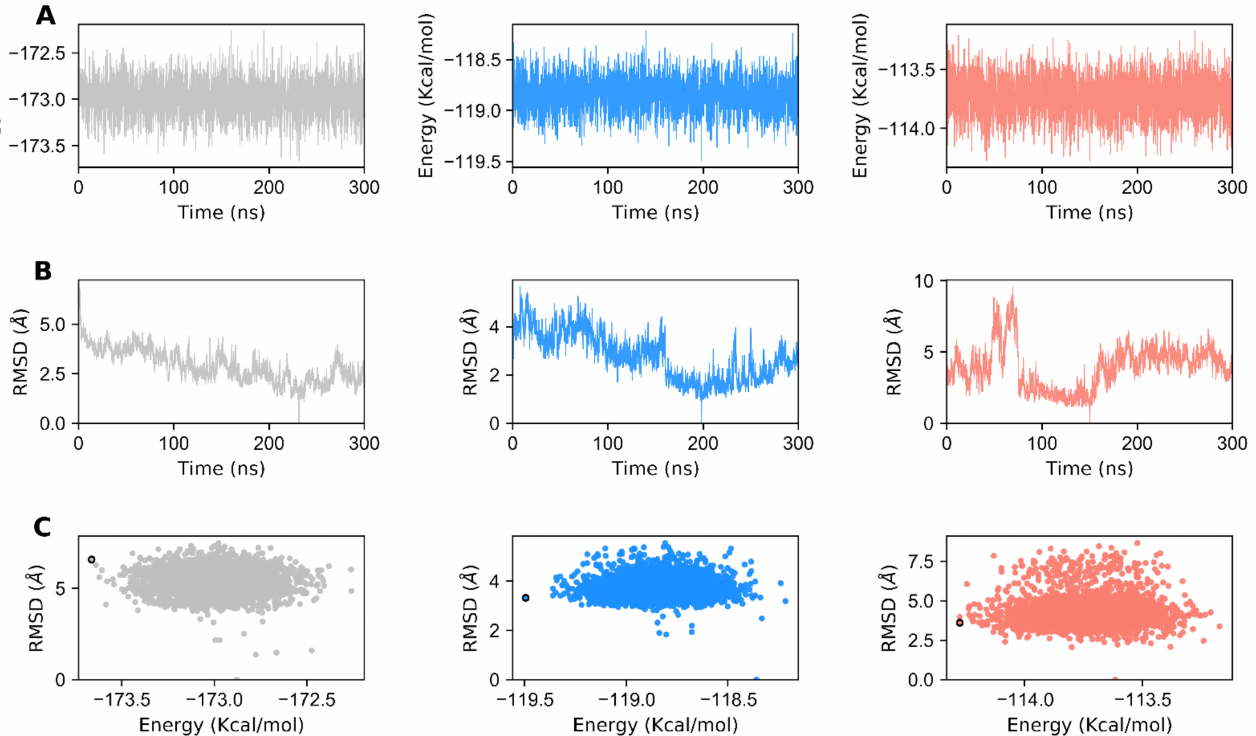
Figure 5. Generation of minimal energy structures of GDH for network analysis. ( A ) Time-dependent total conformational energy of apo, agonist-, and antagonist-bound GDH states. ( B ) RMSD with reference to the minimal energy structure from the MD trajectories of GDH states. ( C ) Total conformational energy versus RMSD plots for apo, agonist- and antagonist- bound GDH complexes. The minimal energy structures of GDH states are shown as black circles. The data for apo, agonist-and antagonist-bound forms of GDH are shown in gray, dodger blue, and salmon, respectively. Network centrality is used as a popular method for elucidating protein allostery.